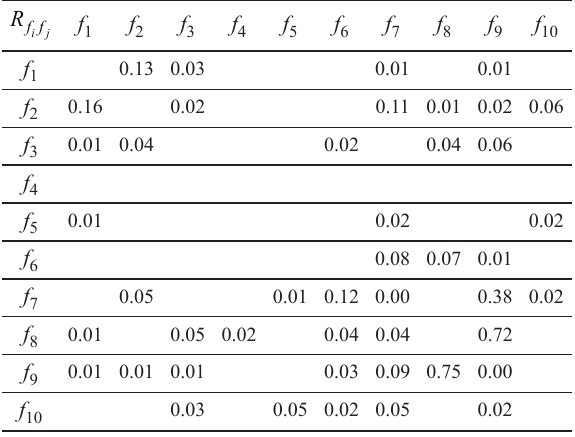
Table 3. Movement relation of functions f i and f